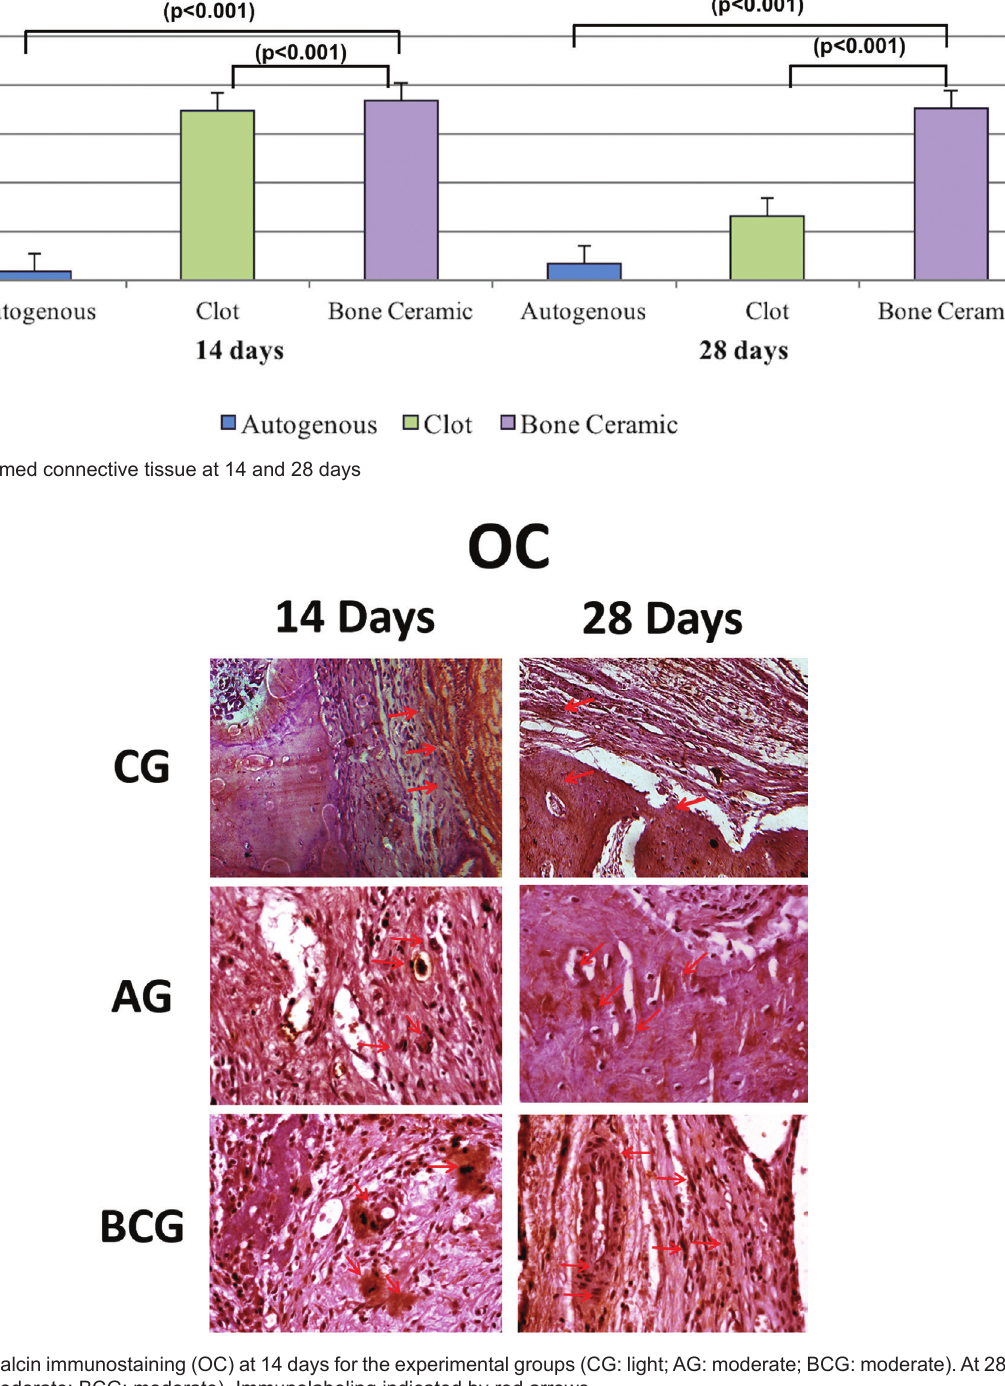
Figure 5- Osteocalcin immunostaining (OC) at 14 days for the experimental groups (CG: light; AG: moderate; BCG: moderate). At 28 days (CG: light; AG: moderate; BCG: moderate). Immunolabeling indicated by red